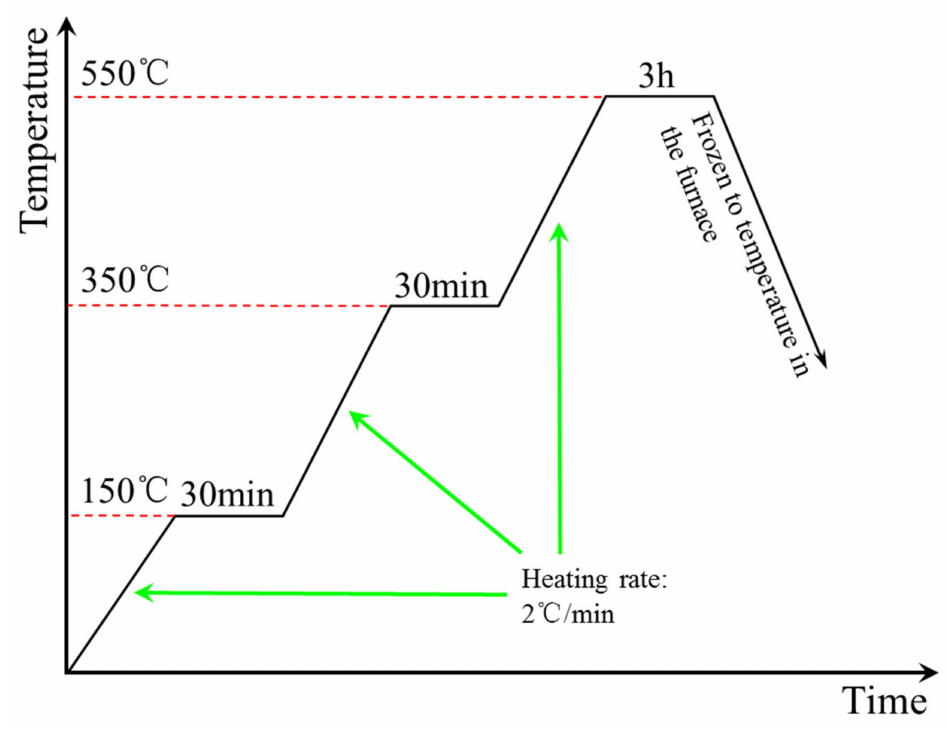
Figure 2. Sintering process curve of composite